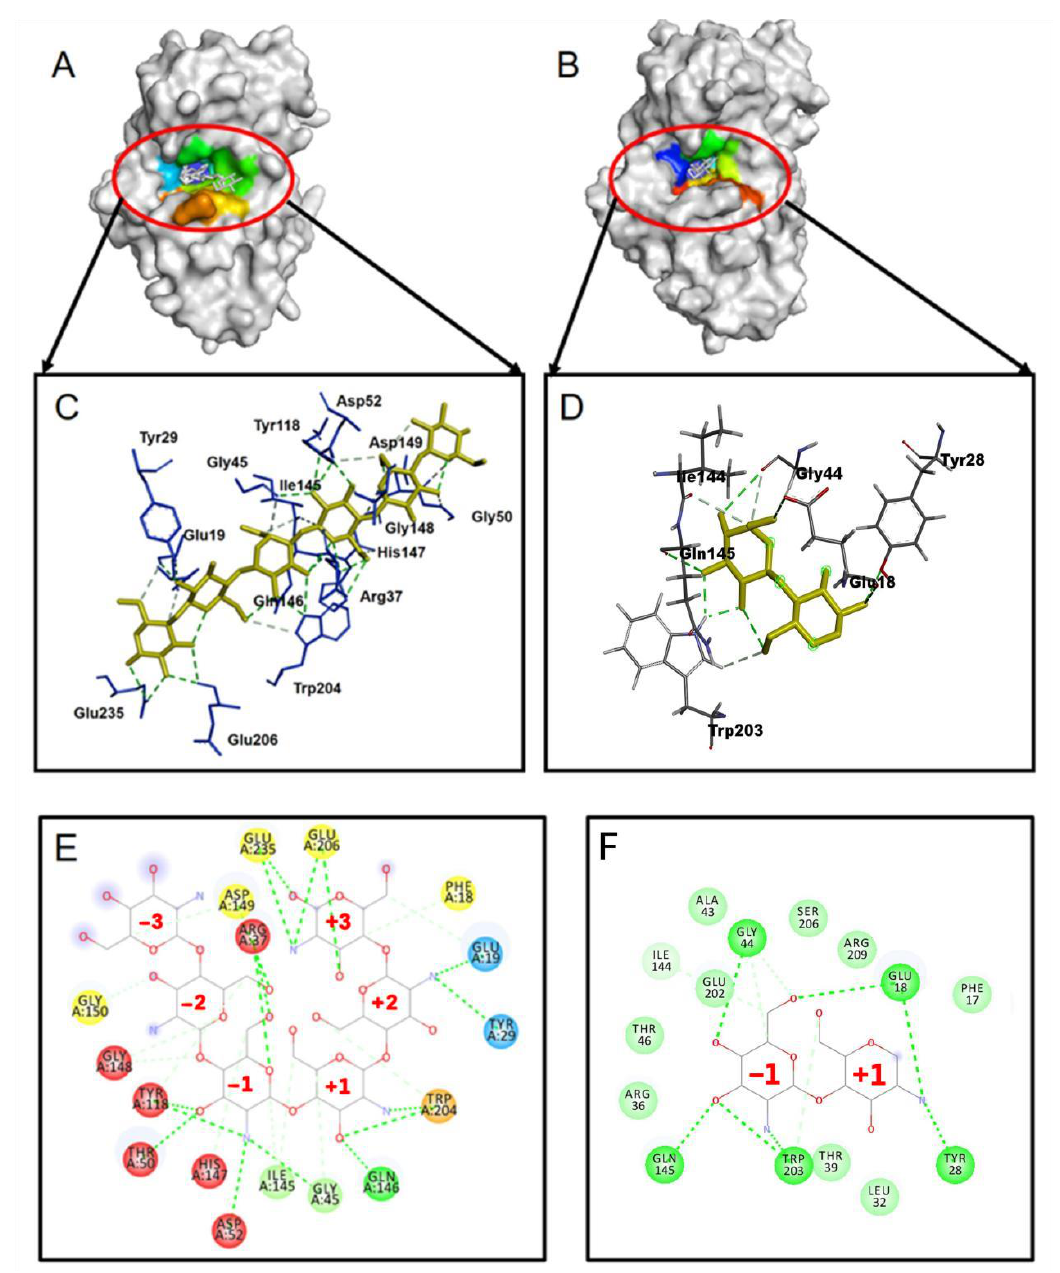
Figure 1. ( A ) Docking pose of (GLCN) 6 ; ( B ) docking pose of (GlcN) 2 ; ( C ) residues involved in (GLCN) 6 binding; ( D ) residues involved in (GLCN) 2 binding; ( E , F ) subsites for (GlcN) 6 ; ( E ) and (GlcN) 2 ( F ) binding: subsite − 1 (red), subsite +1 (black).